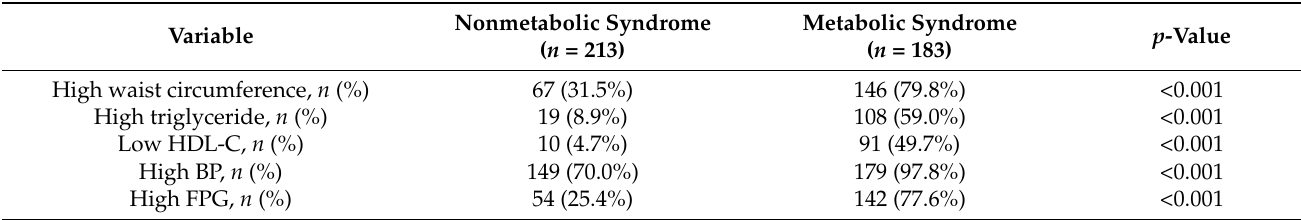
Table 2. The percentage of participants who met the criteria for metabolic syndrome.